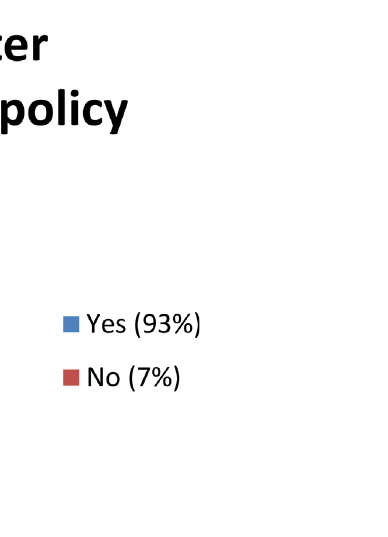
Fig 2. Respondents better prepared to monitor